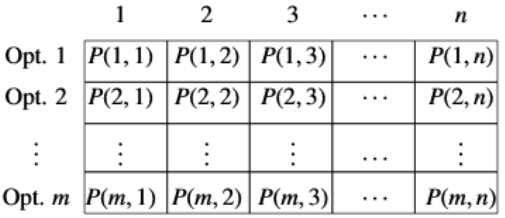
Figure 2. Structure of the probability matrix